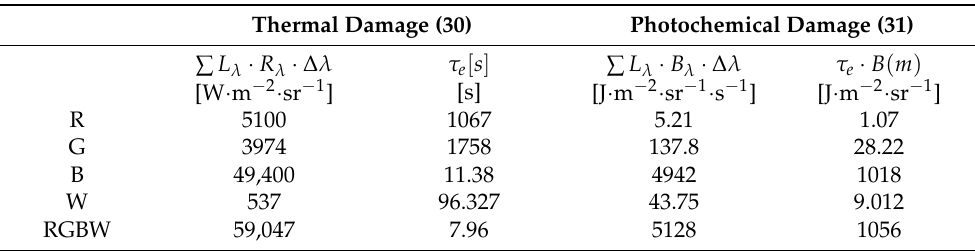
Table 1. Threshold limits of human eyesight